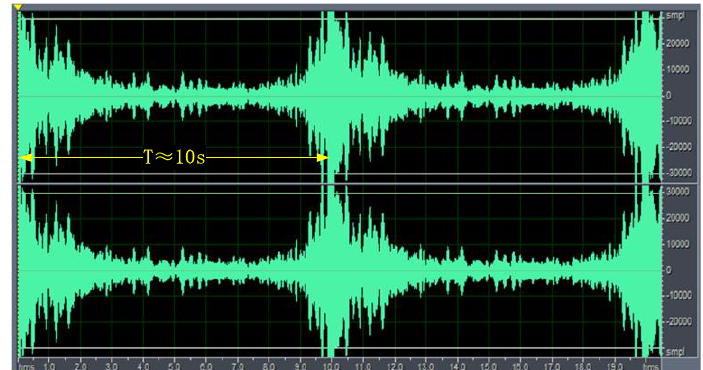
Figure 14. The collected IQ data of the surveillance channel with multiple antenna rotation periods.